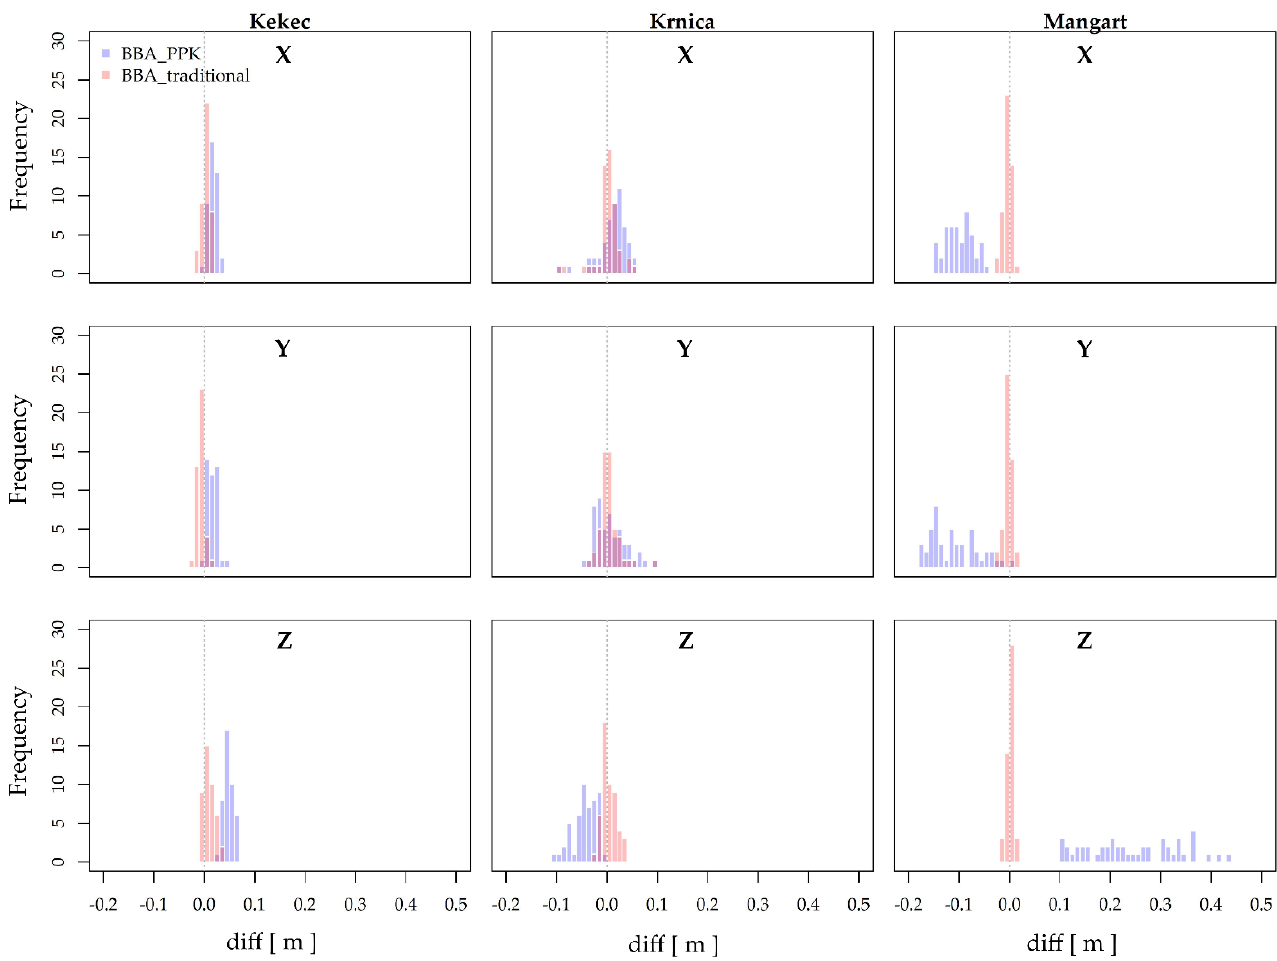
Figure 6. Frequency distribution of the X, Y and Z coordinates’ differences at all three rockfall sites for BBA_traditional and BBA_PPK. Bar width is set to 0.01 m.